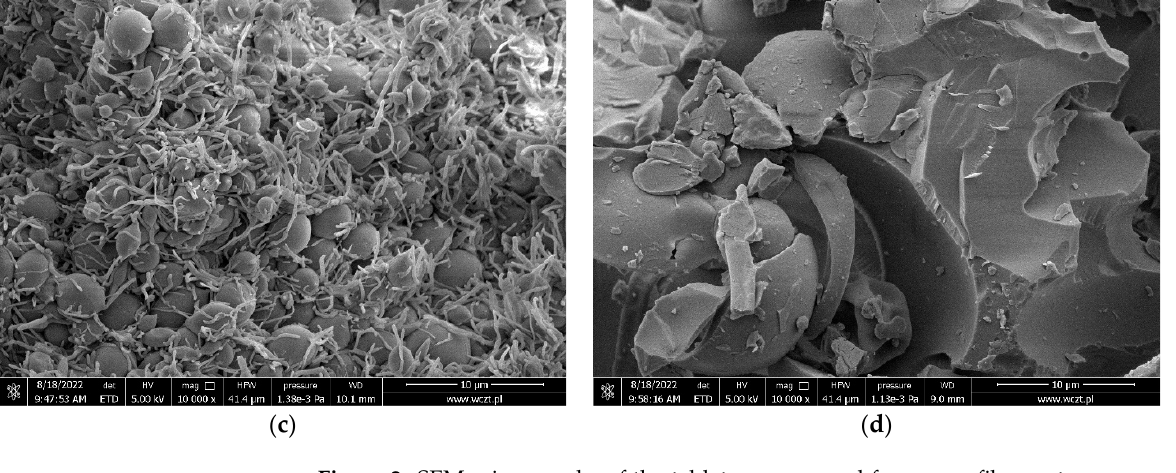
Figure 2. SEM micrographs of the tablets compressed from nano fi bers, at a compression force of 500 N ( a ), 750 N ( b ), and 1000 N ( c ), and powder, at a compression force of 750 N ( d ).